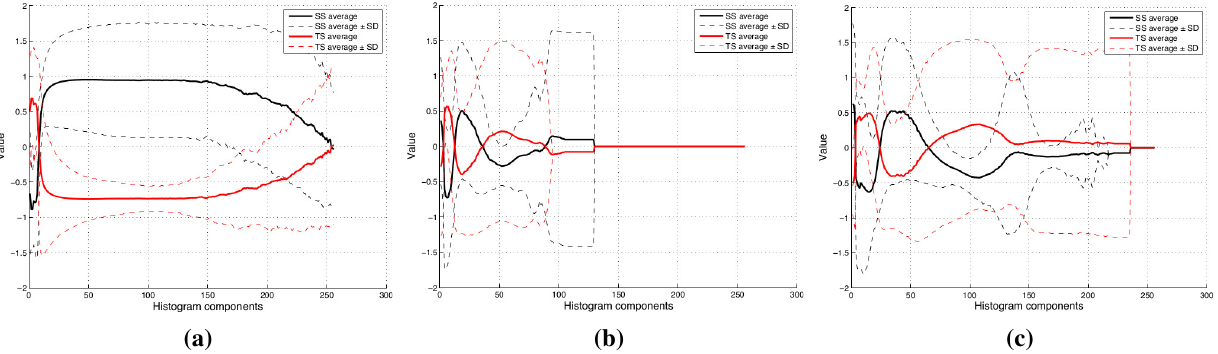
Figure 7. This figure shows the normalized image histograms after applying the textural filter ( a ), channel R minus channel G operation ( b ) and channel R minus channel B operation ( c